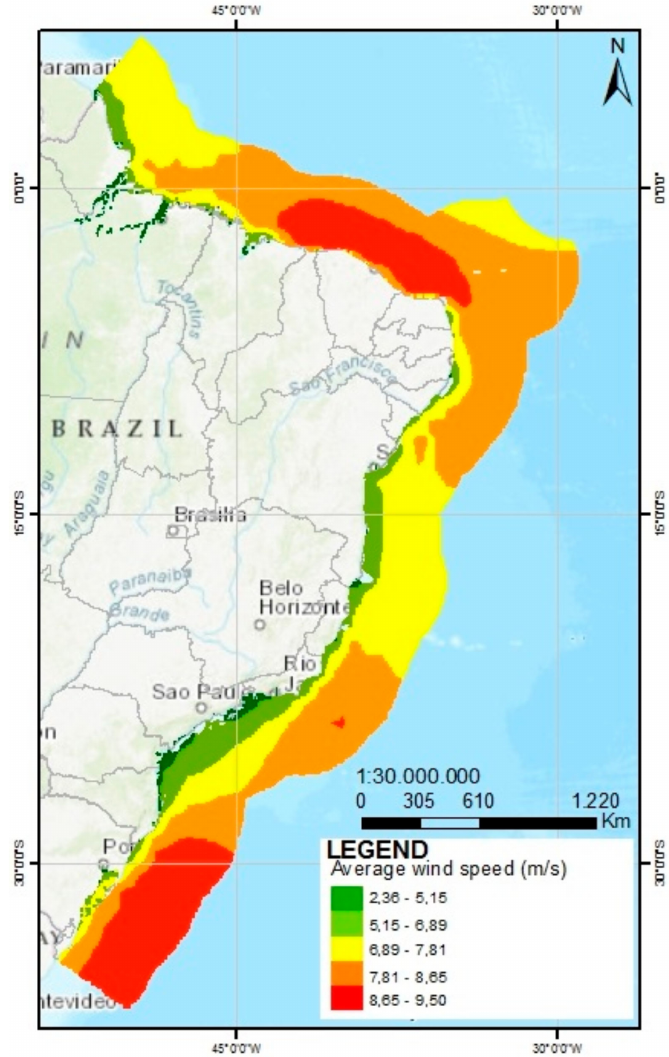
Figure 7. Wind resource at 100 m height. Source: